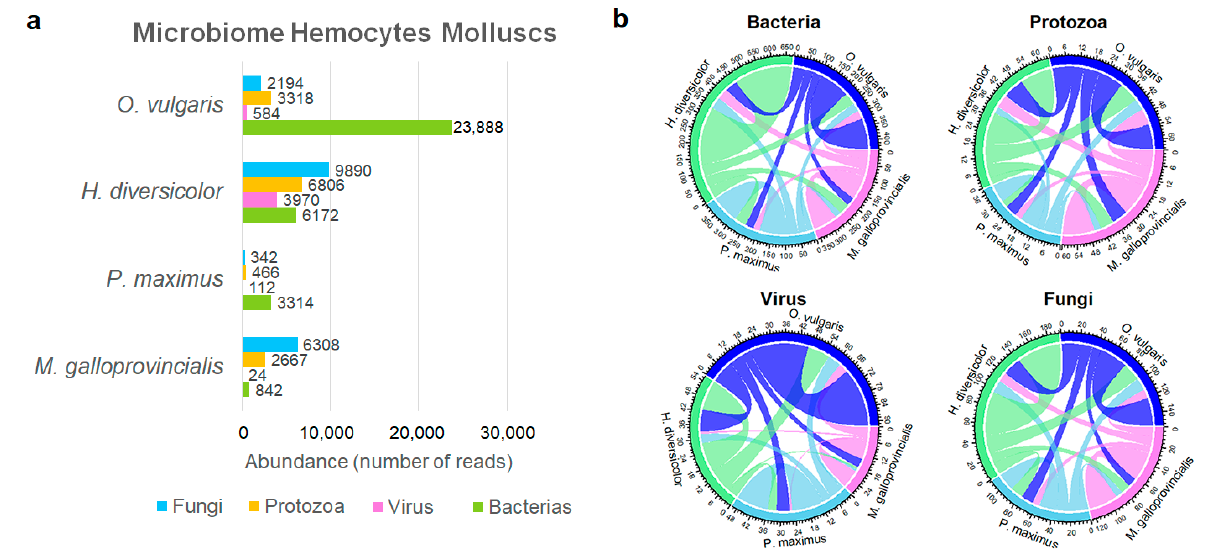
Figure 7. Metatranscriptome comparison between the haemocytes of 4 mollusc species. ( a ) Abun- dances of each group in the 4 studied species. Numbers indicate the quantity of reads that mapped in each group. ( b ) Chord diagram showing the number of taxa shared by each pair of species.